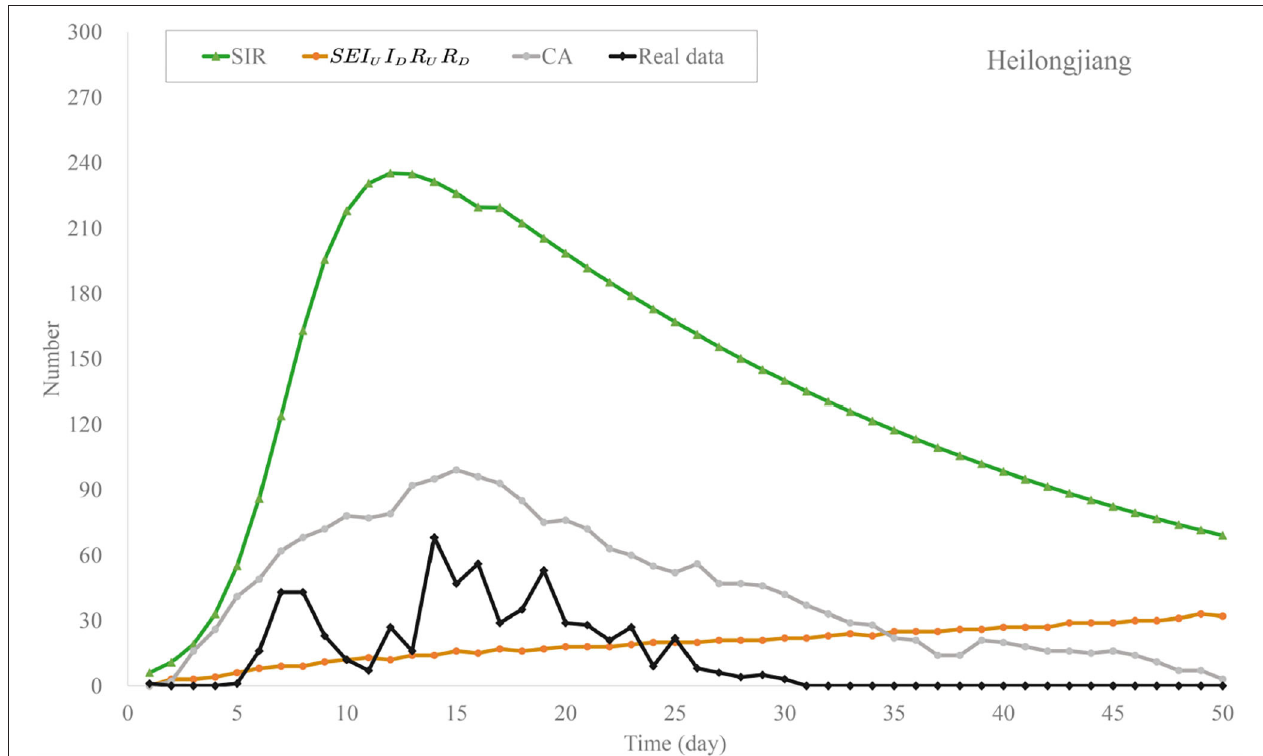
FIGURE 5 | Trend chart of daily confirmed cases of the models in Heilongjiang province.